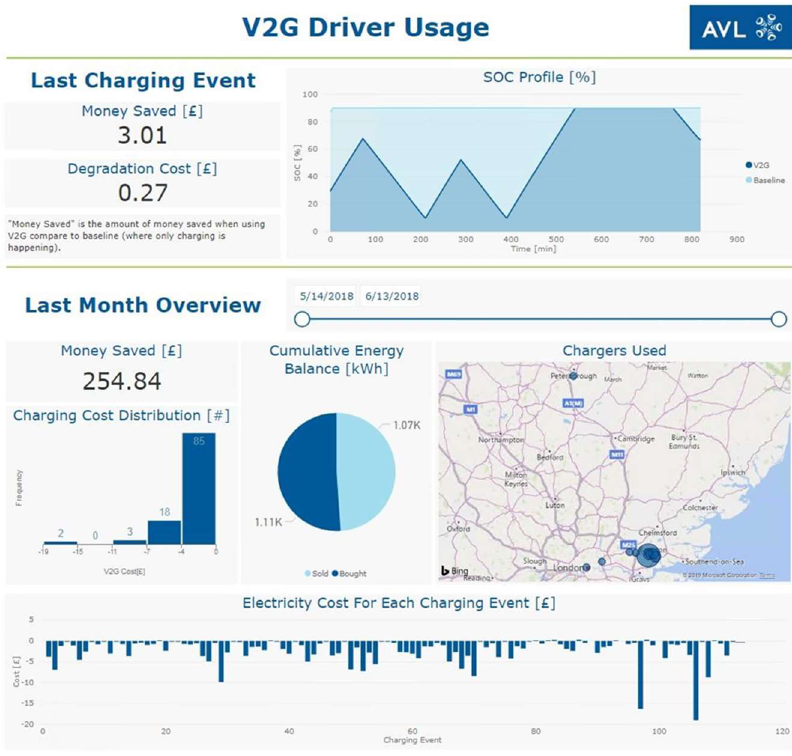
Figure 15. BEV owner’s dashboard.